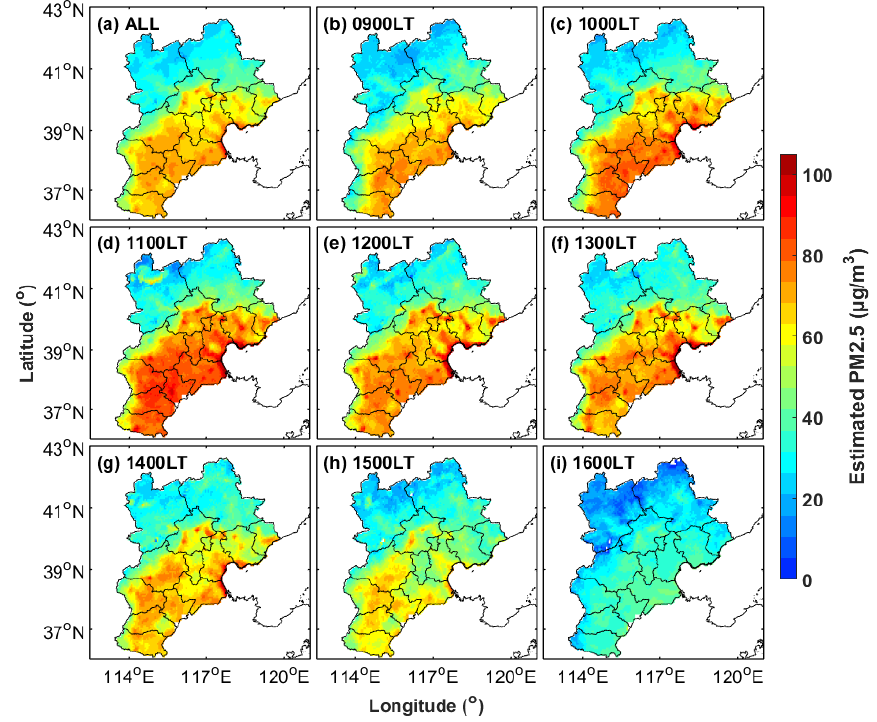
Figure 7. Spatial distribution of averaged PM2.5 estimations obtained from improved LME model for ( a ) all available data and ( b – i ) different hours (0900–1600 local time). The study period is from July 2015 to March 2017.